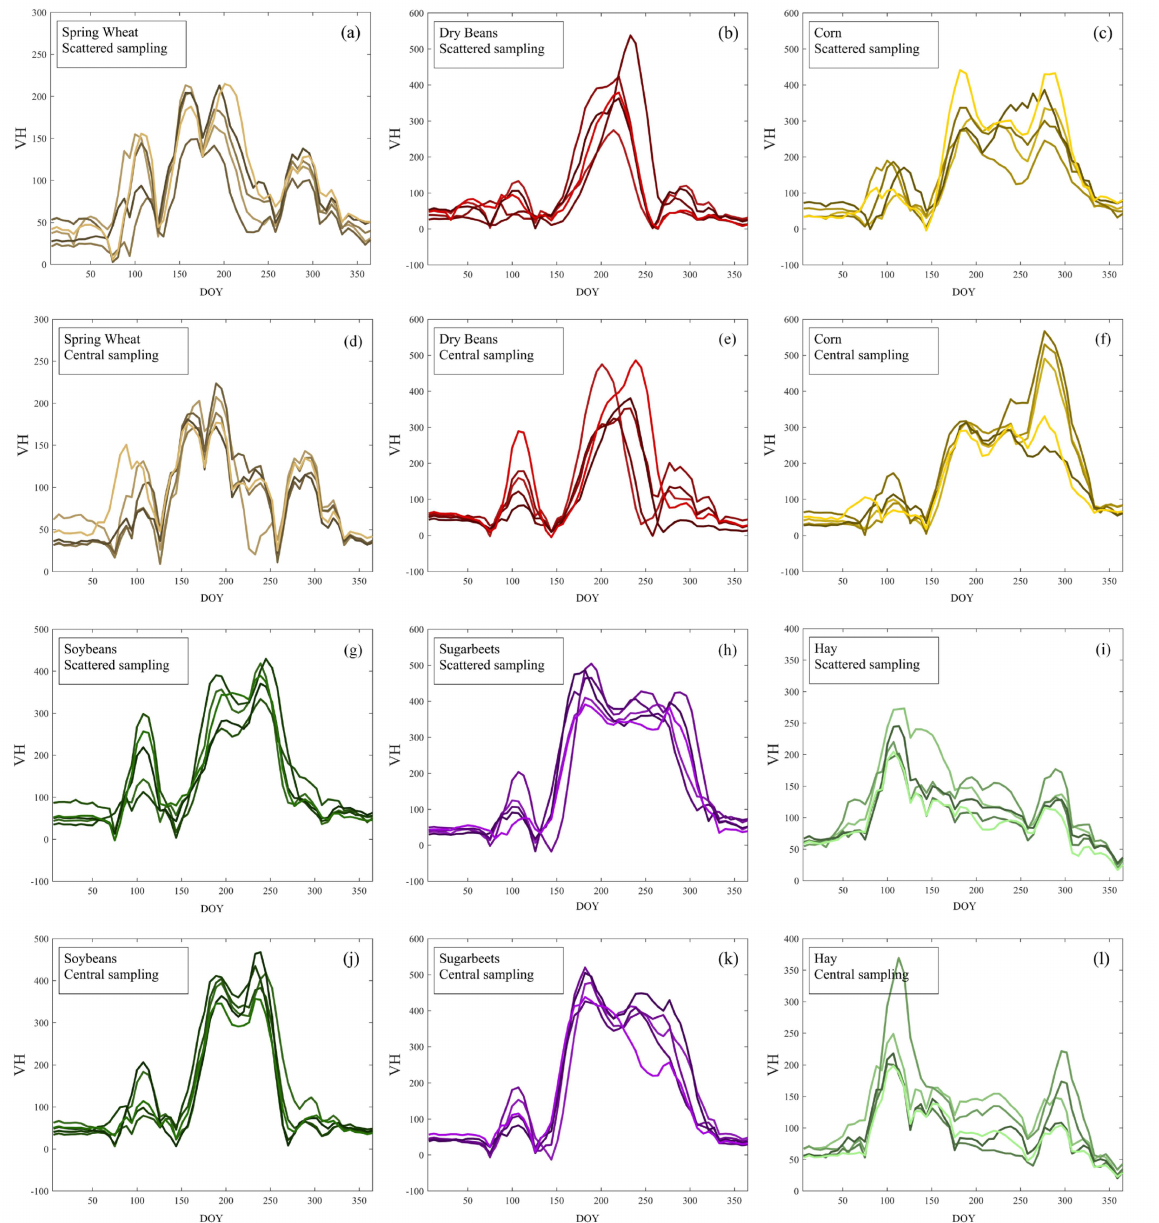
Figure 5. SG filter time series curves of different crops under scattered and central sampling